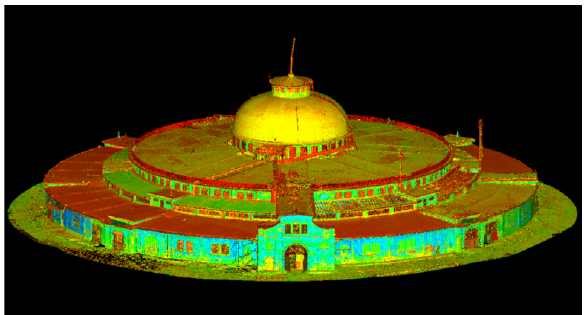
Figura 4. View, with scale of color based on value of reflectance, of the global 3-D model of Stazione Frigorifera. Both internal and external parts of the model were divided into different layers (that correspond to the different architectonical elements: groundfloor, first floor and dome) in order to have a more manageable spatial dataset and the possibility to work separately with each part of the